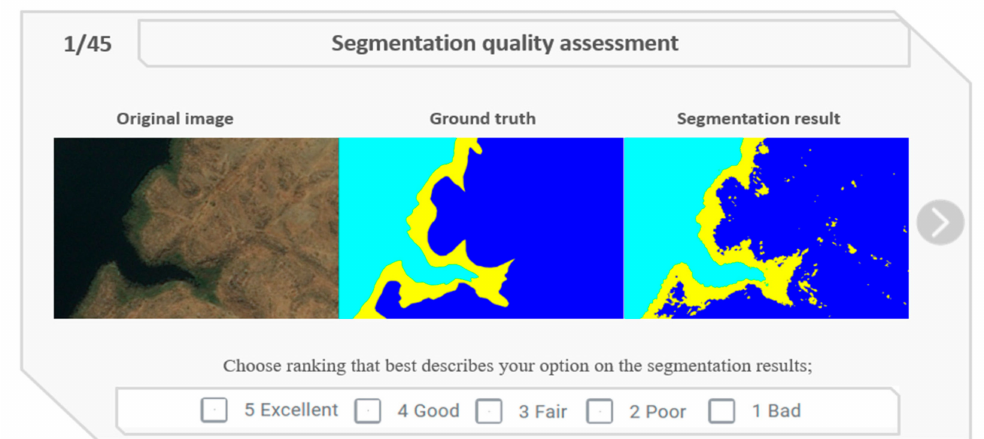
Figure 4. Example of the electronic form for segmentation quality assessment using the absolute category rating (ACR) scale. Di ff erent image clusters are marked with selected colours in “Ground truth” and “Segmentation result”